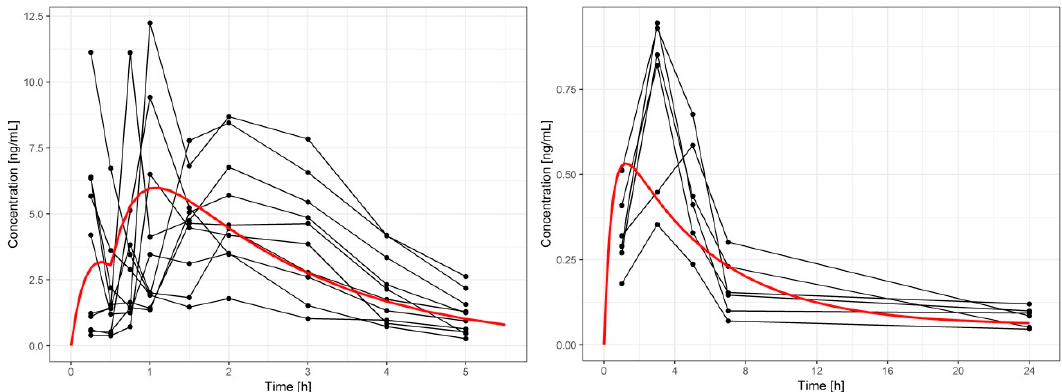
Figure 2. Plasma concentration profiles of tetraene after an oral dose of 1 mg ( left ) and a transdermal dose of 0.64 mg ( right ). Circles—measurements; black lines connect the same subject. Plasma concentration–time course in a typical subject (population prediction) is shown by the red curve.